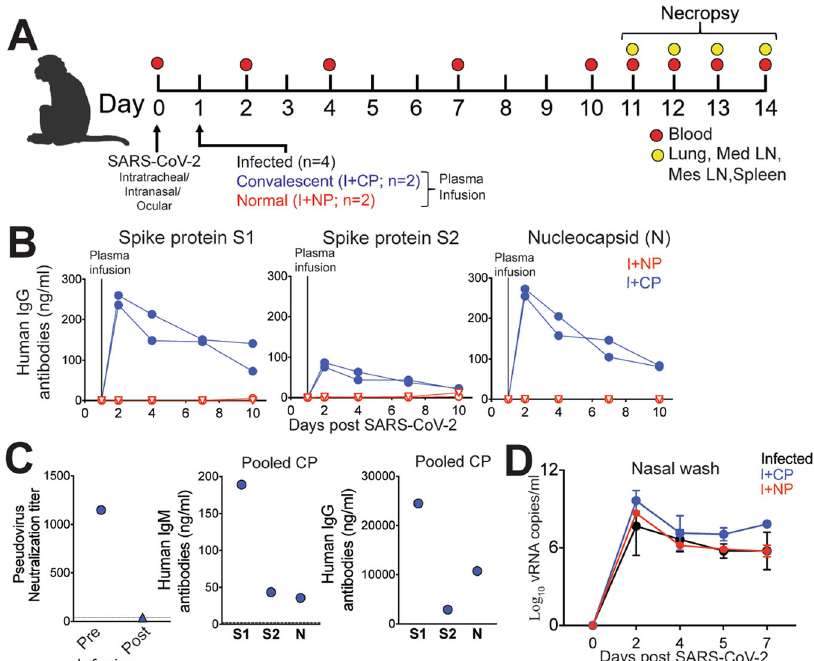
Fig. 1 Experimental design and convalescent plasma infusion. A Rhesus macaques inoculated with severe acute respiratory syndrome coronavirus 2 (SARS-CoV-2) were infused with COVID-19 convalescent plasma (I + CP), normal plasma (I + NP), or did not receive plasma (infected). B Concentrations of human IgG antibodies against S1, S2, and N following CP infusion. C Concentrations of human IgM and IgG antibodies against S1, S2, and N in pooled CP pre-infusion. Pseudovirus neutralization of CP pre-infusion and pooled macaque sera post infusion. D Mean viral RNA ( + SD) in nasal washes (kinetic data shown derived from independent animals, sample size for experimental groups: n = 4 infected, n = 2 I + CP, and n = 2 I +